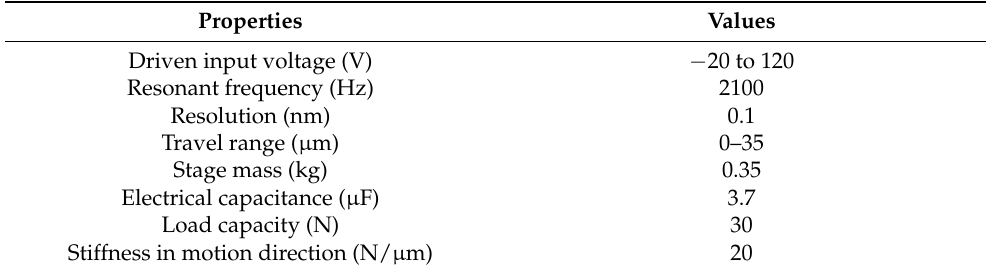
Table 2. Typical properties of the considered piezoelectric